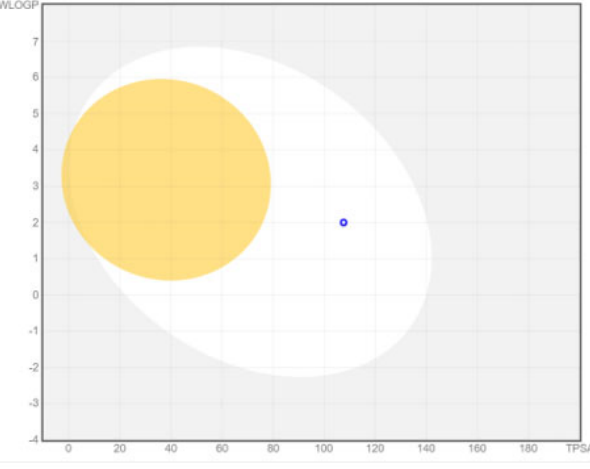
Figure 9. Boiled egg model of chain-engineered dolutegravir predicted by Swiss ADME; blood–brain barrier (yellow), gastrointestinal tract (white), drug (blue dot).